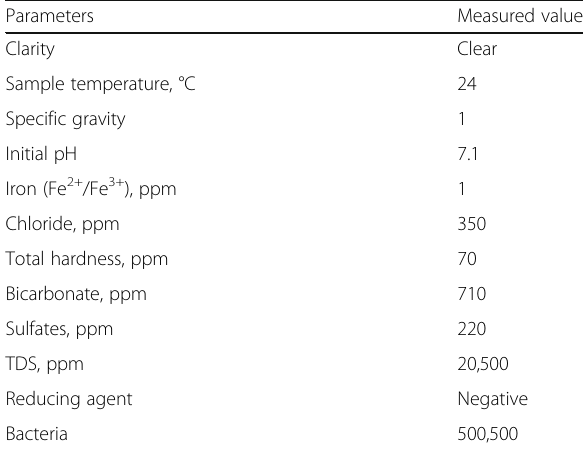
Table 1 Test1 (sample water)